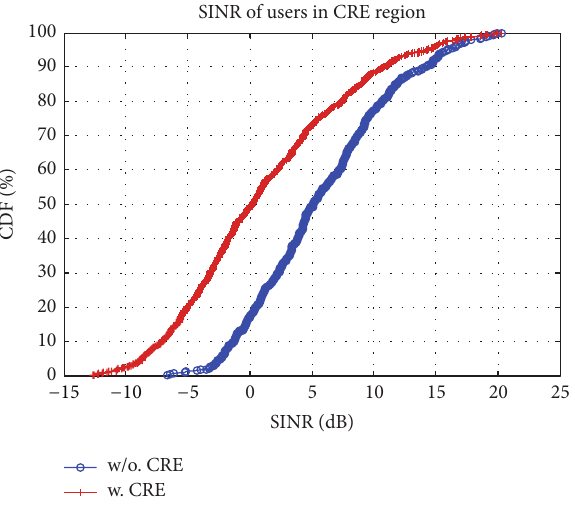
Figure 2: SINR of users in range extension